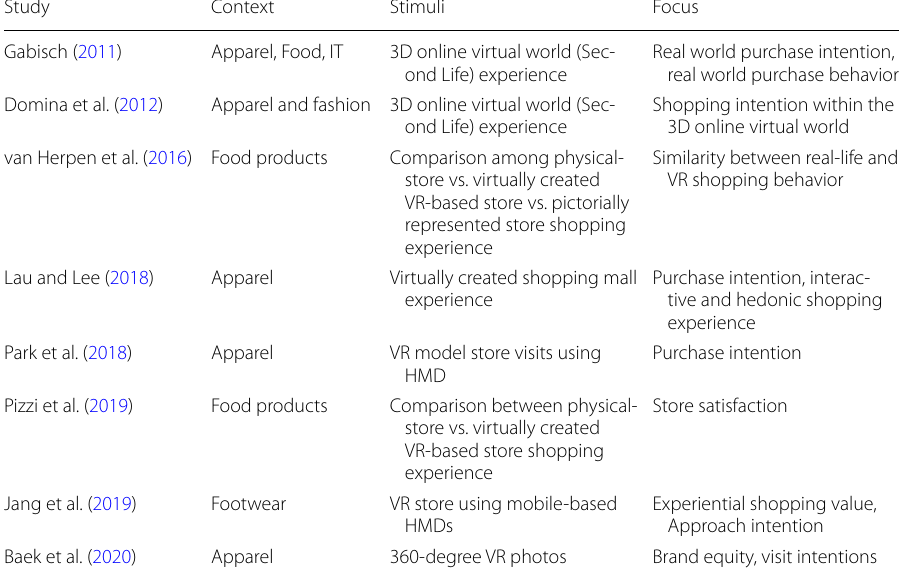
Developed by authors based on literature